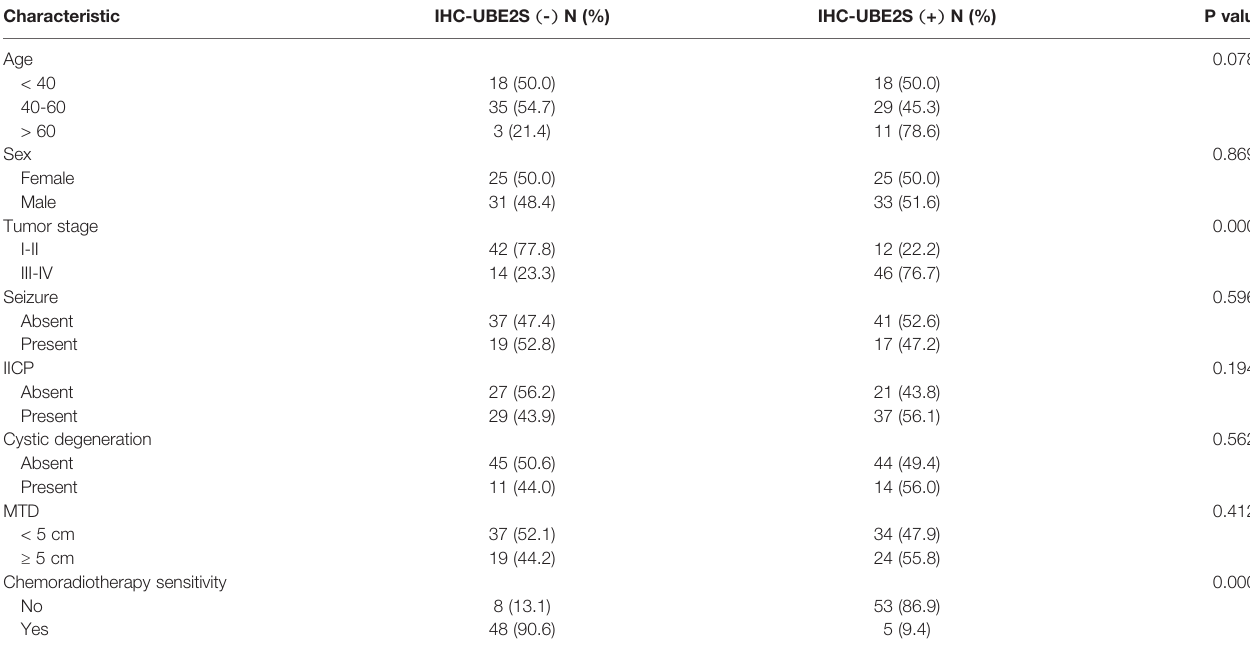
TABLE 1 | Clinicopathological characteristics of glioma patients for immunohistochemical investigation.